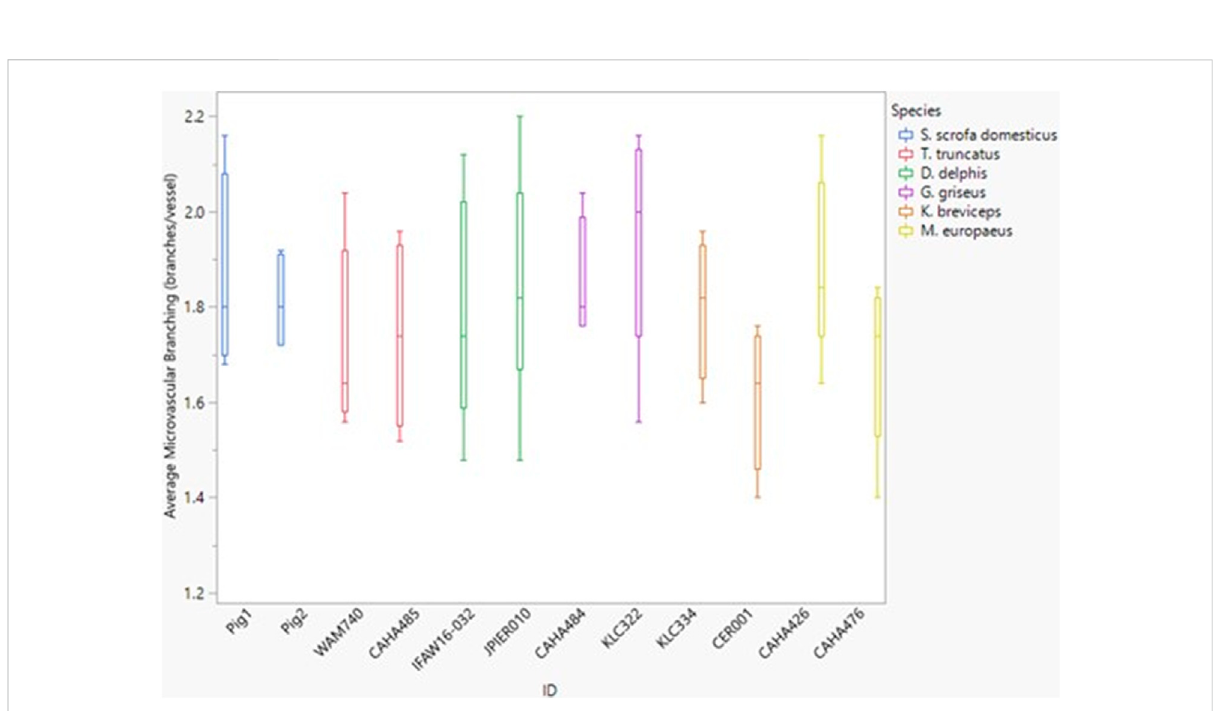
FIGURE 5 Box and whisker plot of average microvessel branching versus Animal ID color-coded by species. Horizontal lines from top to bottom: maximum, third quartile, median, fi rst quartile,